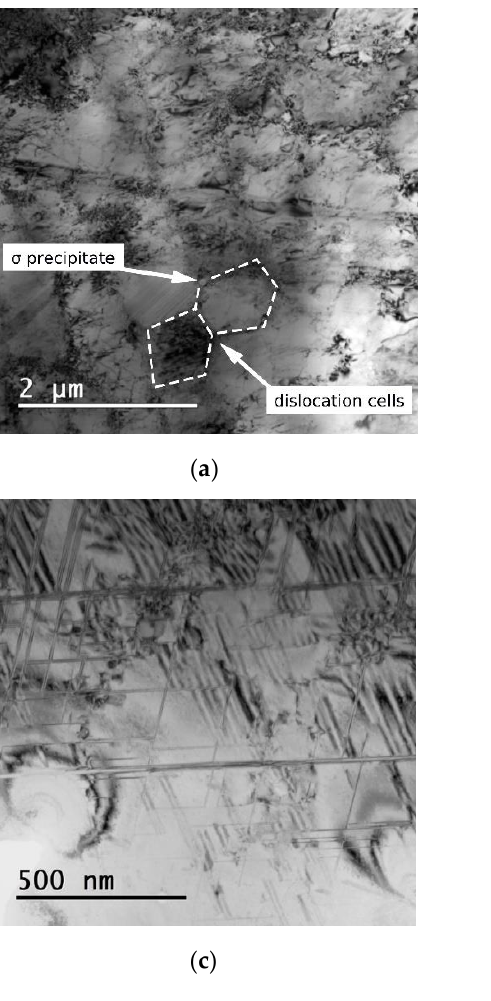
3D-printed Co-Cr-Mo alloy: ( a ) dislocation cells; ( b ) hcp lamellae; ( c ) nucleation of hcp lamellae at stacking faults, ( d ) selected area electron diffraction (SAED)